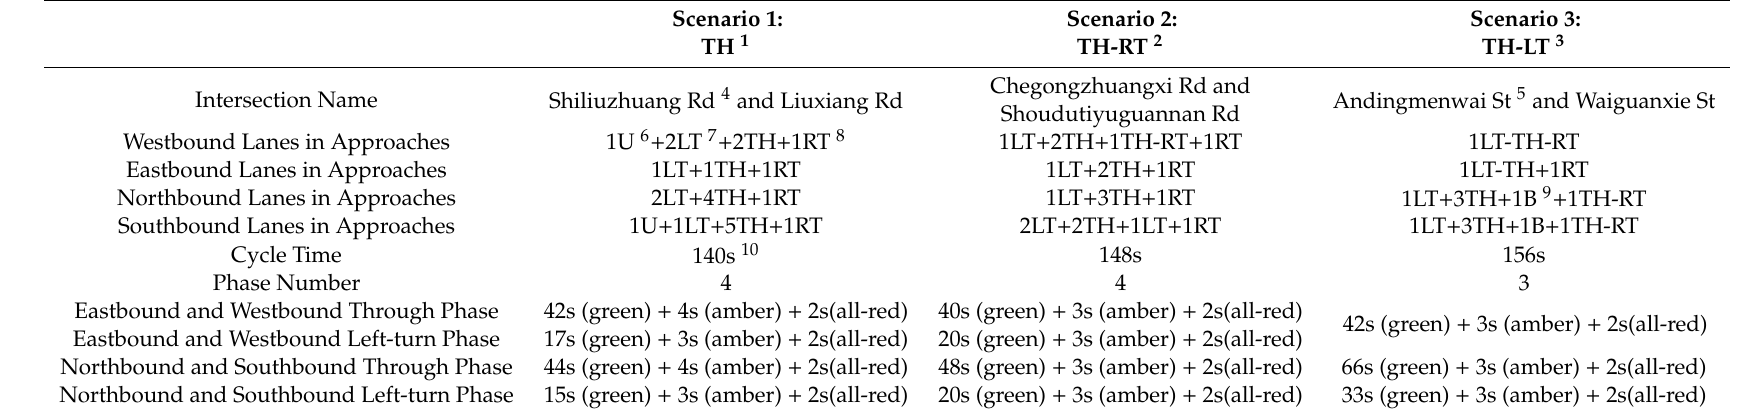
Table 2. Location of three tra ffi c scenarios and the detailed